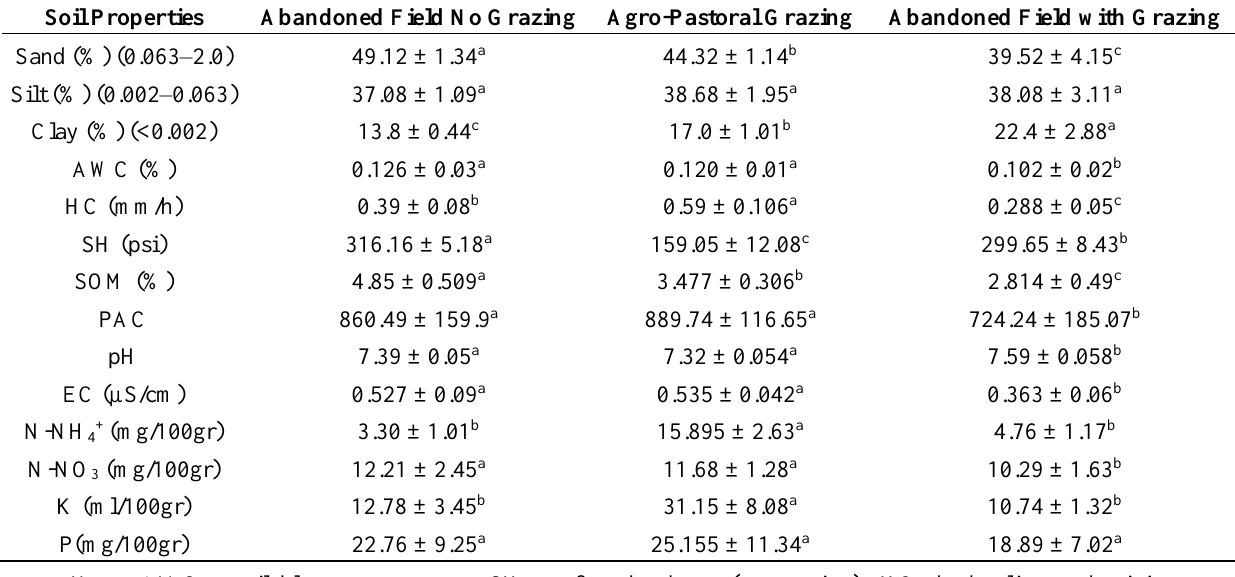
Table 1. Soil quality properties for the Migda site, Israel, with the following treatments: (A) abandoned field no grazing; (B) agro-pastoral grazing; and (C) abandoned field with grazing. Statistics include: average value, standard deviation (SD), and indication of significant differences between treatments represented with small letters (a, b, c).